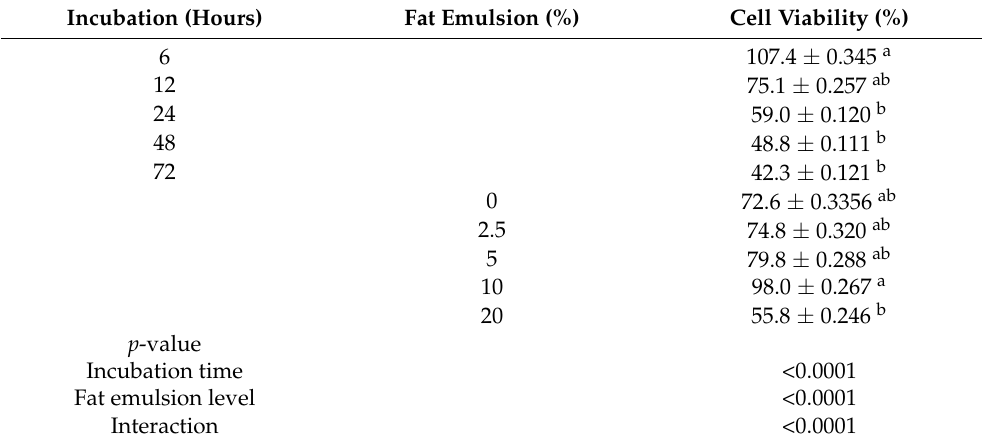
Table 3. Effect of different concentrations and different times of fat emulsion on hepatocyte